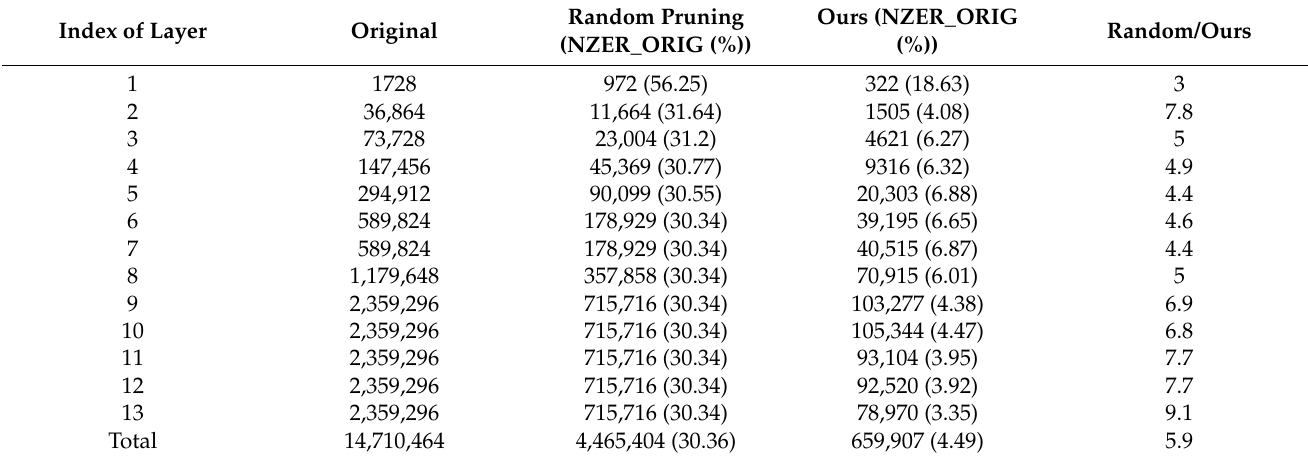
Table 4. The number of nonzero elements in each layer (from the 1st to the 13th) for the 45% pruning rate on VGG-16.